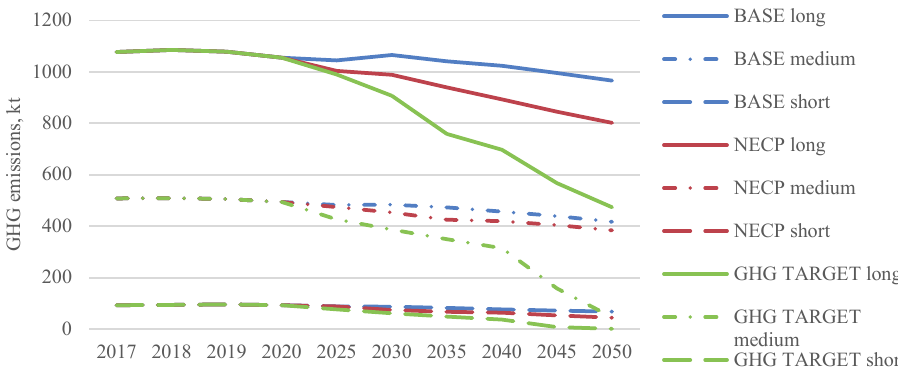
Fig. 18. Projection of GHG emissions by